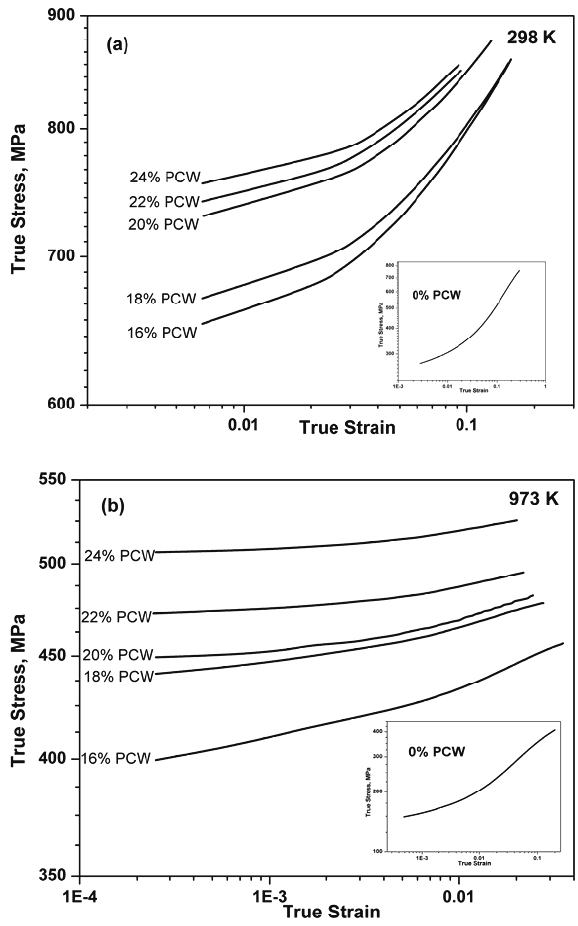
Figure 2. Double logarithmic plot of true stress-true strain curve of IFAC-1 with the insert showing the plot for 0% PCW at (a) 298 K and (b) 923 K.